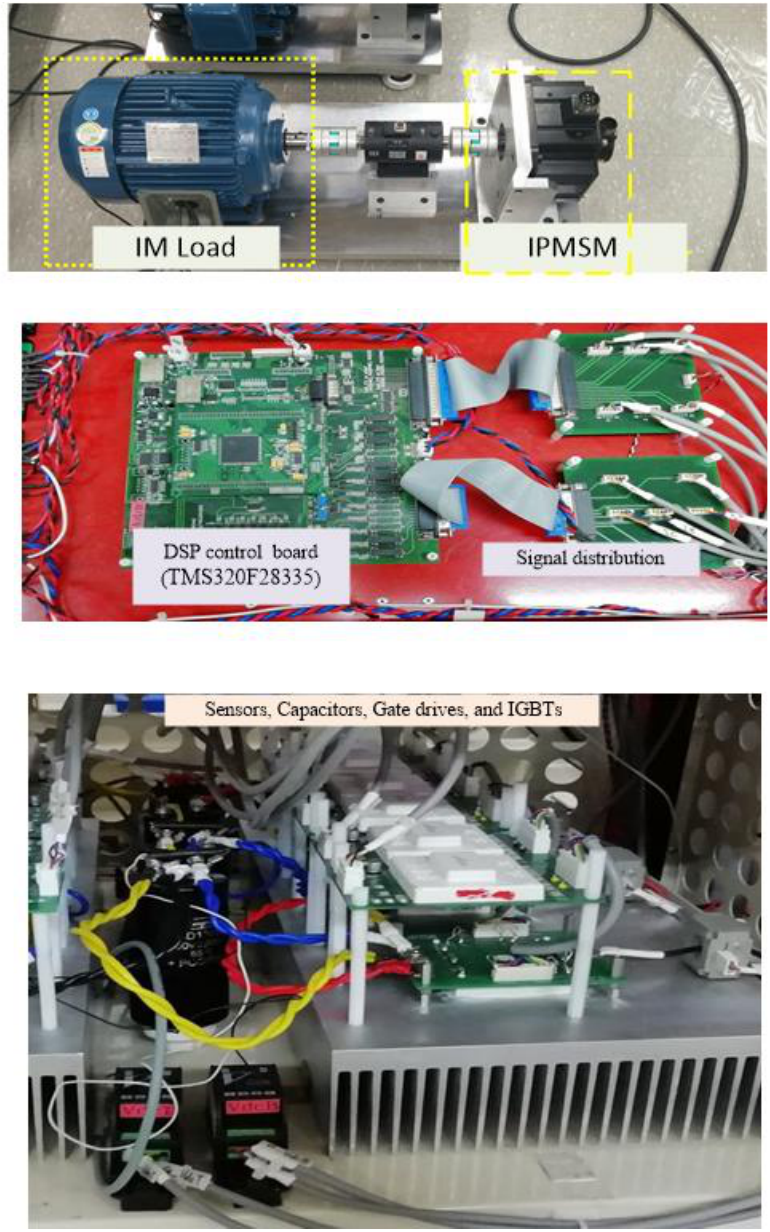
Figure 6. Experimental setup. Table 4. PMSM Parameters.